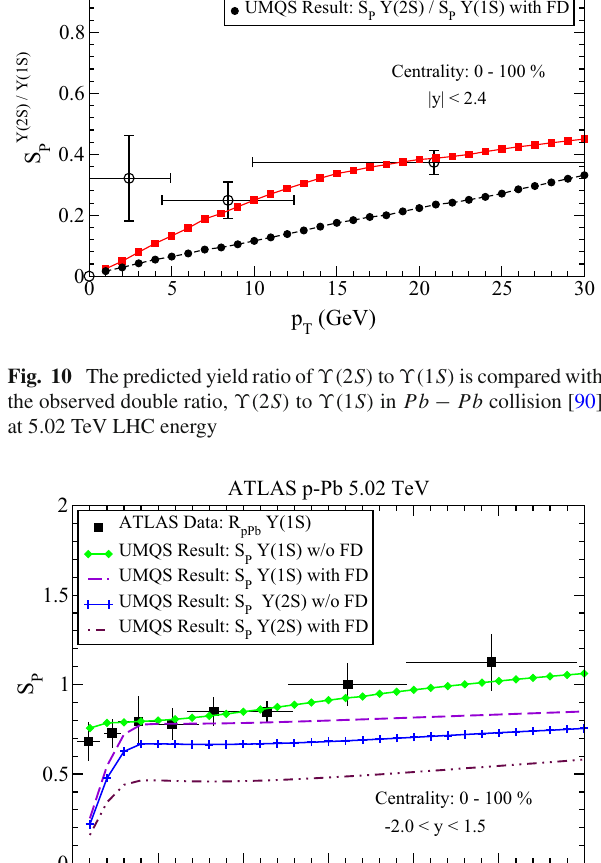
AA [92] in p–Pb collisions at √